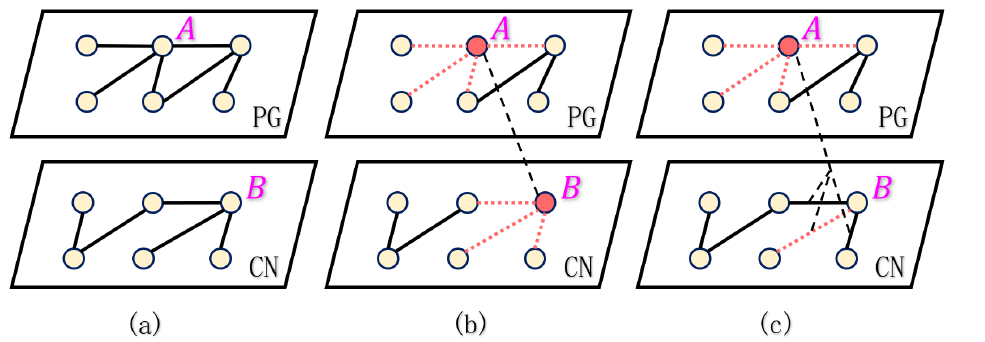
Figure 1. The diagram of failure propagation. Nodes A and B are interdependent. ( a ) Without failure; ( b ) Node–Node failure propagation; ( c ) Node–Link failure